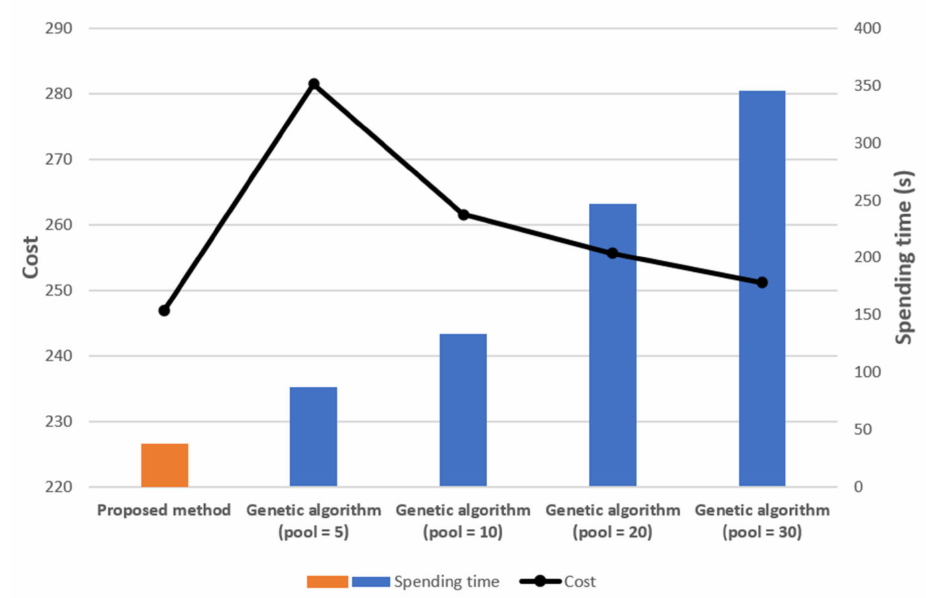
Figure 15. The comparison for the genetic algorithm and our methodology for 40 nodes topology in Figure 14